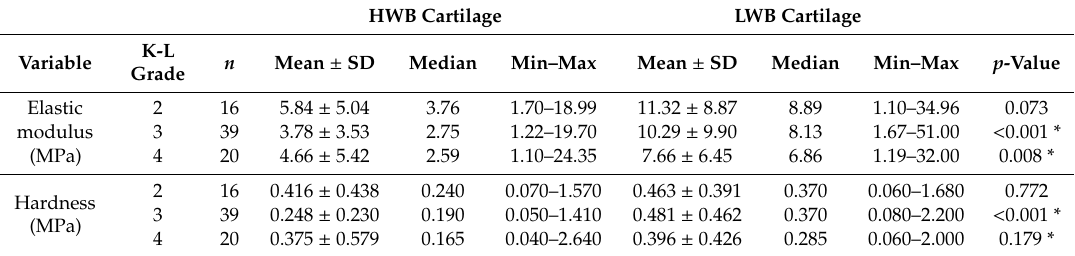
Table 5. Elastic modulus and hardness of high weight bearing (HWB) and low weight bearing (LWB) articular cartilage adjusted to the Kellgren–Lawrence (K-L) osteoarthritis (OA) grading system. HWB Cartilage LWB Cartilage Variable